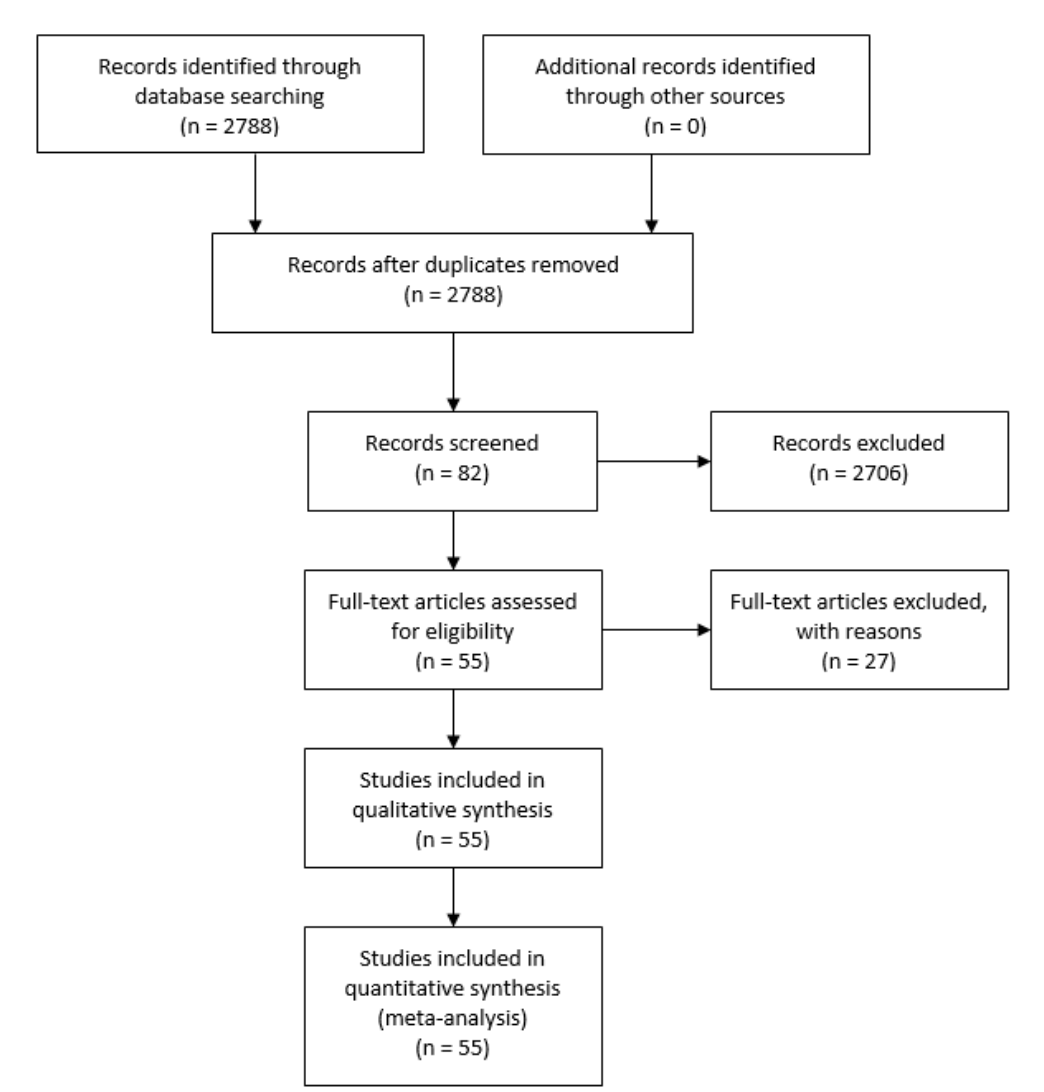
Figure 1. Flow diagram to show the study-selection